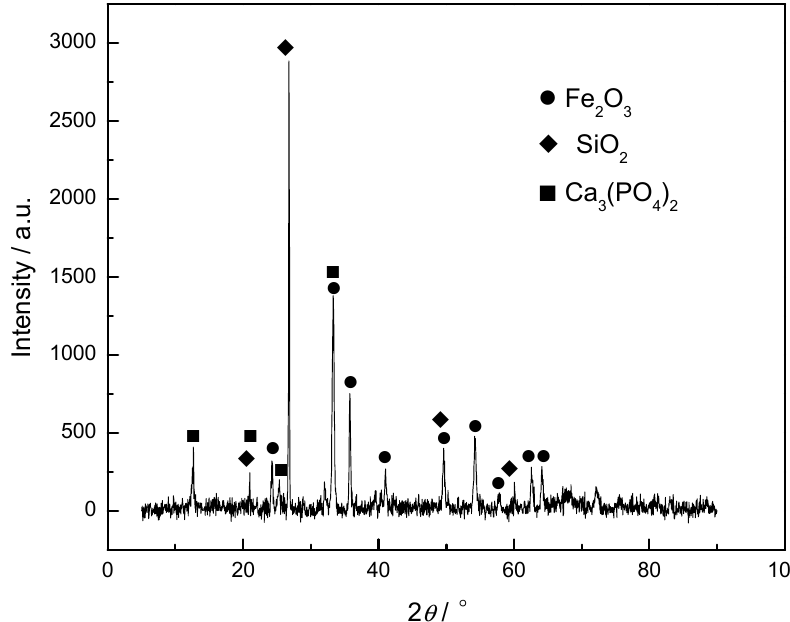
Figure 2. XRD pattern of high phosphorus oolitic iron ore.